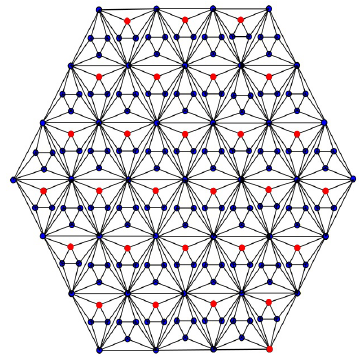
Figure 2. Hex-derived network of type 3 ( HDN 3 ( 4 )